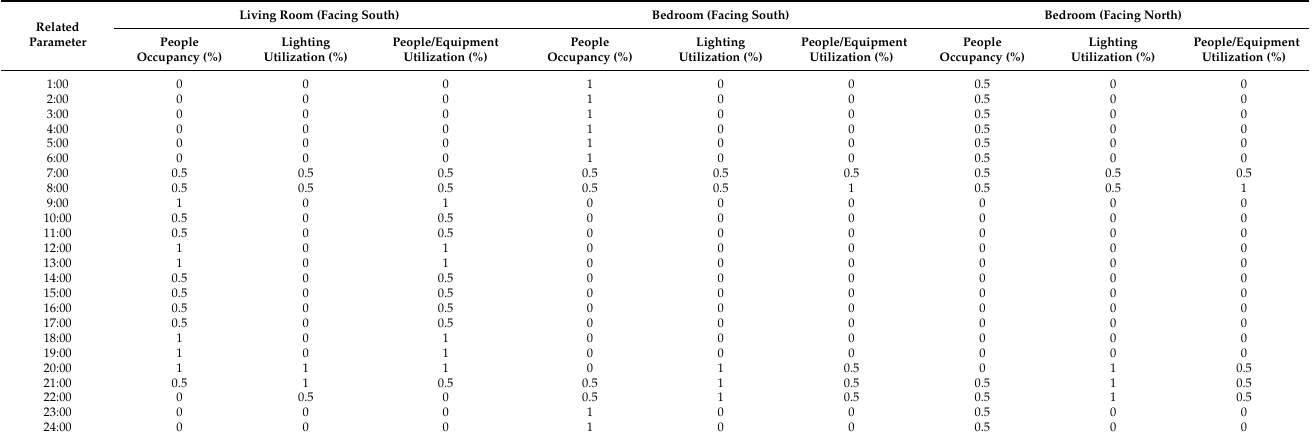
Table A2. Shows the occupancy, lighting, and equipment used in the simulated setting. Internal gain settings and occupancy periods of the simulation